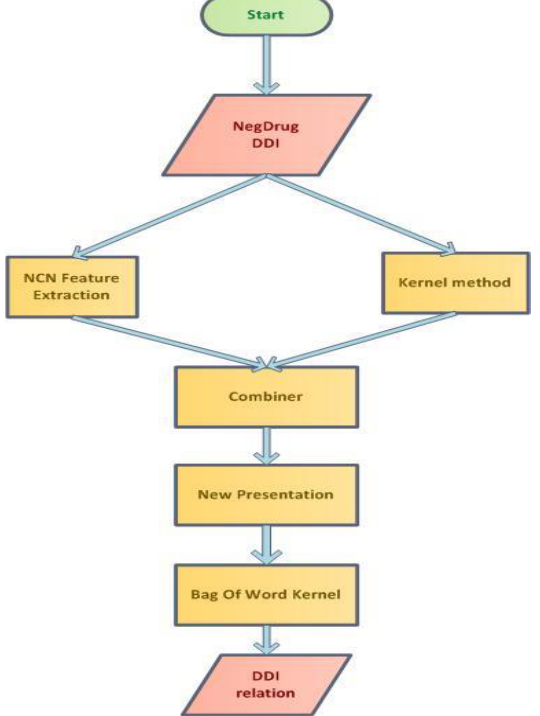
Figure 2. The Basic components of the implemented and proposed